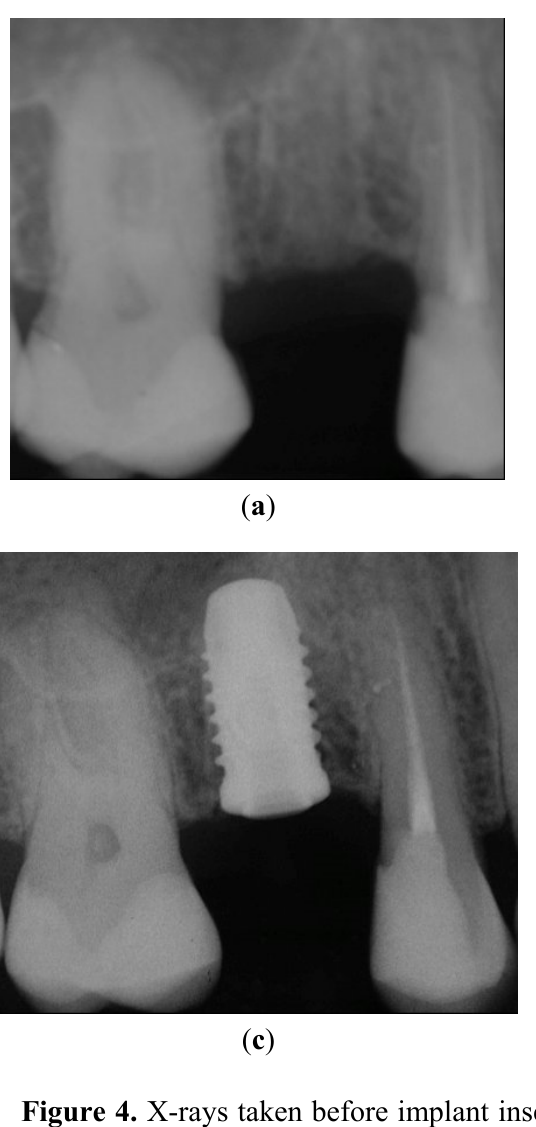
Figure 3. Changes of parodontal parameters. No difference was observed between PFS and StE implants. ( a ) Pocket depth; ( b ) attachment height.